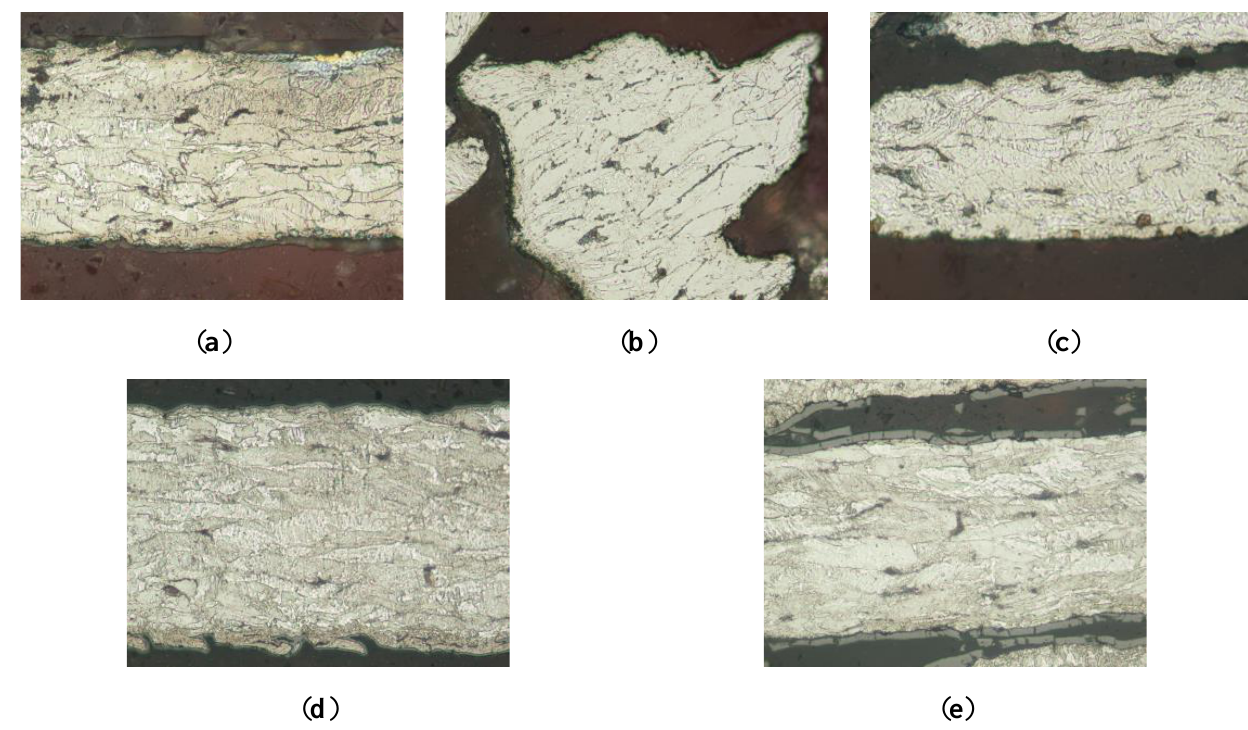
Figure 3. Optical microscopy analysis of the wool samples after thermal treatment under an inert atmosphere. ( a ) Initial sample, ( b ) sample treated at 200 ◦ C, ( c ) sample treated at 300 ◦ C, ( d ) sample treated at 400 ◦ C, and ( e ) sample treated at 500 ◦ C.